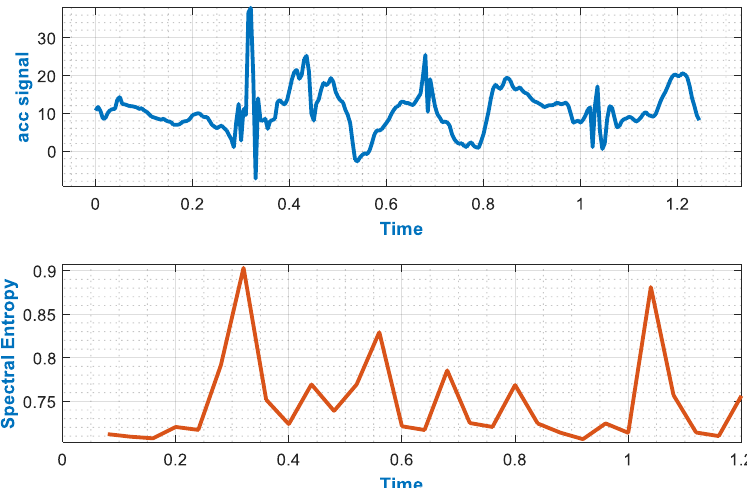
Figure 7. Spectral Entropy for brushing hair signal pattern using the Intelligent Media-Wearable Smart Home Activities (IM-WSHA) dataset.